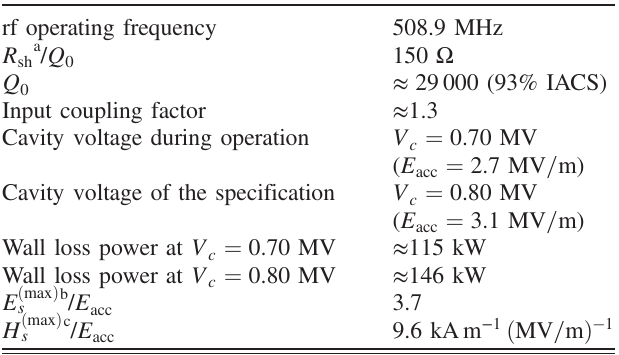
TABLE I. Design parameters of DR cavity No. 0.